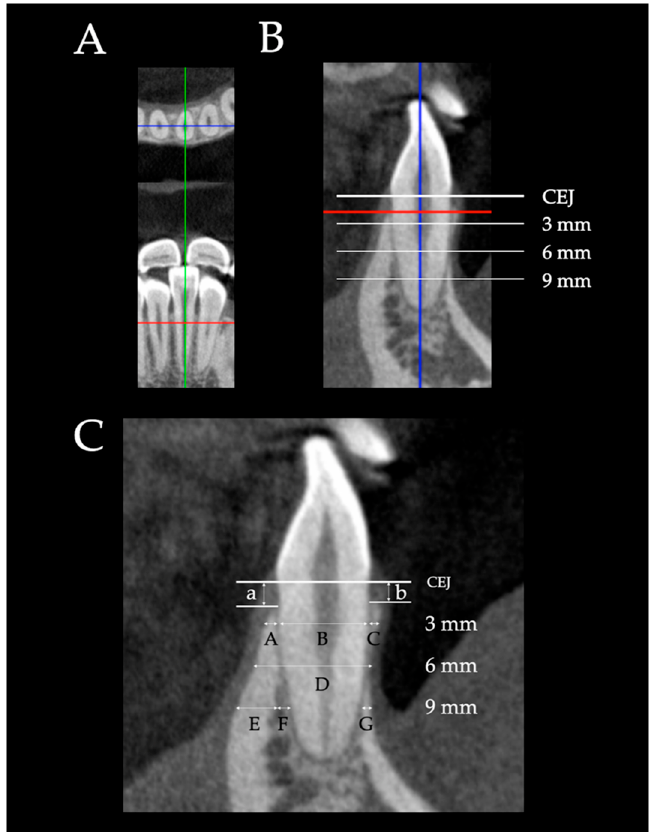
Figure 3. CBCT measurements. ( A ) Tooth orientation of CBCT: The sagittal plane running trans ‐ versely through the midpoint of the tooth long axis. ( B ) The sagittal plane was used to measure the thickness and height parameters of all four incisors in each image. ( C ) On the labial side, labial alveolar bone thicknesses C and G; labial cortical bone thicknesses C and G; labial alveolar bone height b. On the lingual side, lingual alveolar bone thicknesses A and E+F; lingual cortical bone thicknesses A and E; lingual cancellous bone thickness F; lingual alveolar bone height a; and root diameter B and total root ‐ bone thickness D.